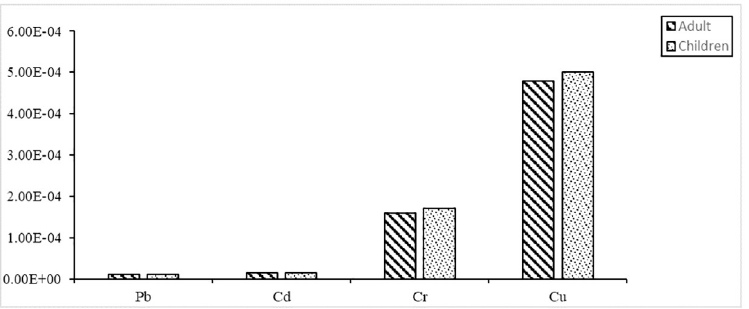
Fig 3. Target carcinogenic risk (TCR) of Pb, Cd, Cr, and Cu in children and adults from broiler chicken meat consumption.